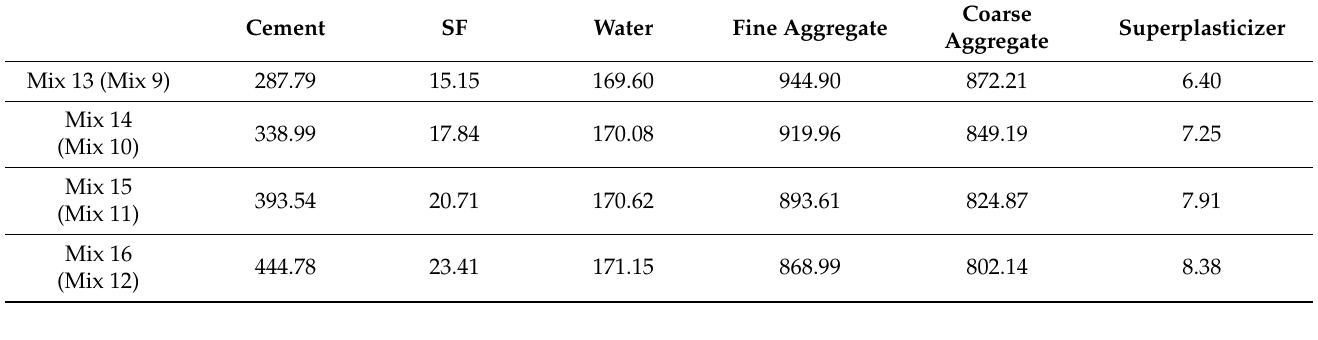
Table 12. Optimal design mixtures for Case 4: low-total-cost concrete with carbonation (unit: kg/m 3 ).